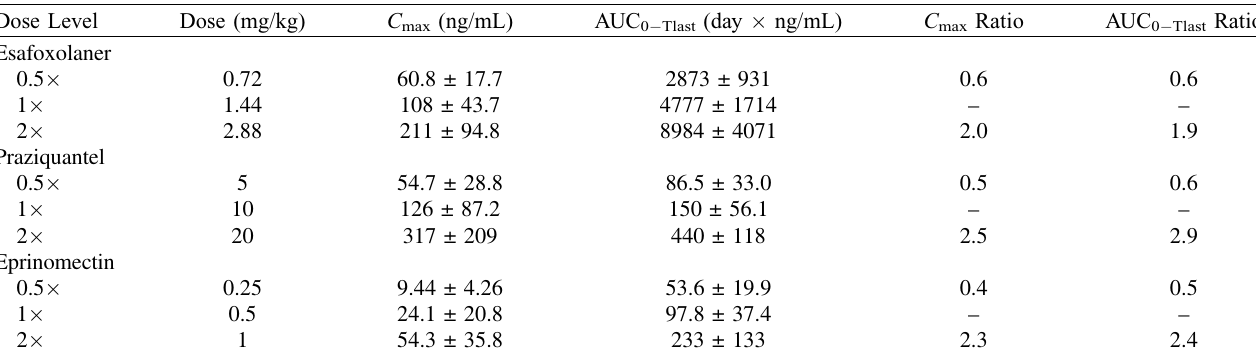
Figure 4. Plots of mean C max values and AUC last values as a function of increasing dose for esafoxolaner, praziquantel and eprinomectin. Table 3. Mean C max and AUC for esafoxolaner, eprinomectin and praziquantel following a topical single administration 0.5, 1 or 2 times the intended minimum dose of the novel